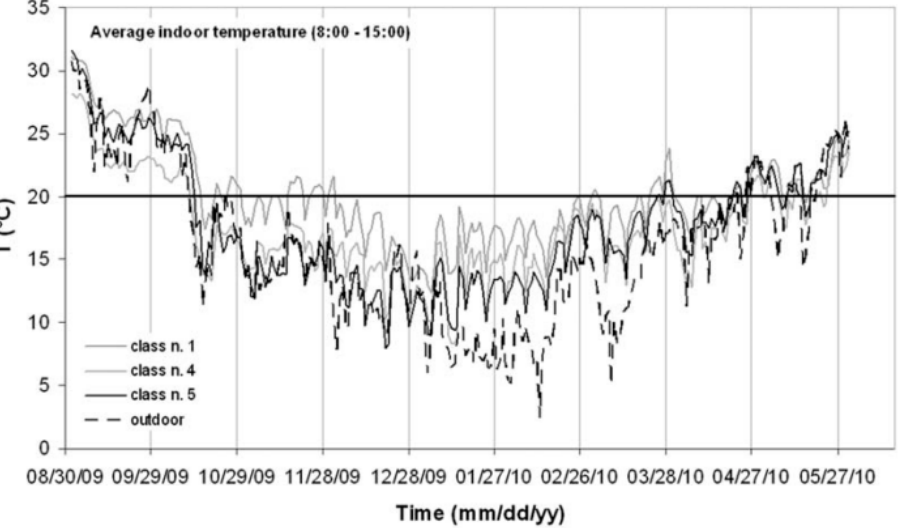
Figure 25. Average temperature throughout the 2009–2010 scholastic year [12].